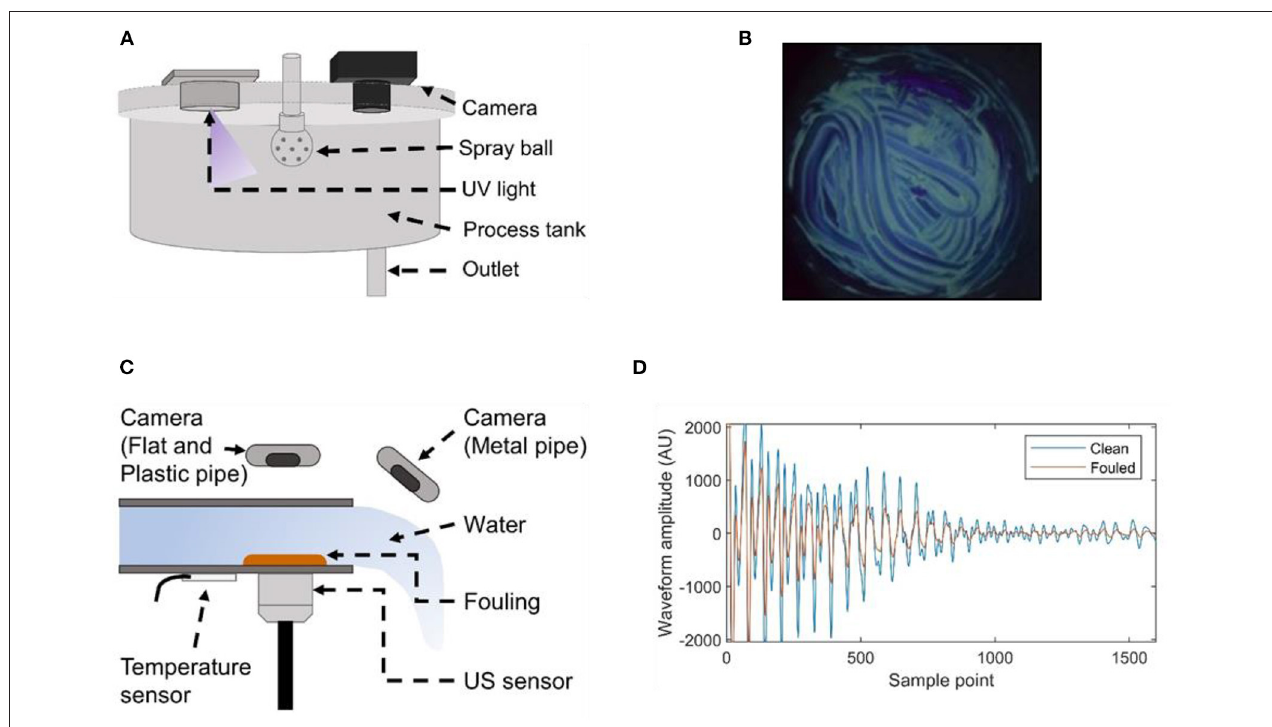
FIGURE 5 | Experimental setups for optical (A) and ultrasonic measurements (C) and examples of the data recorded by the optical (B) and ultrasonic sensors (D) .